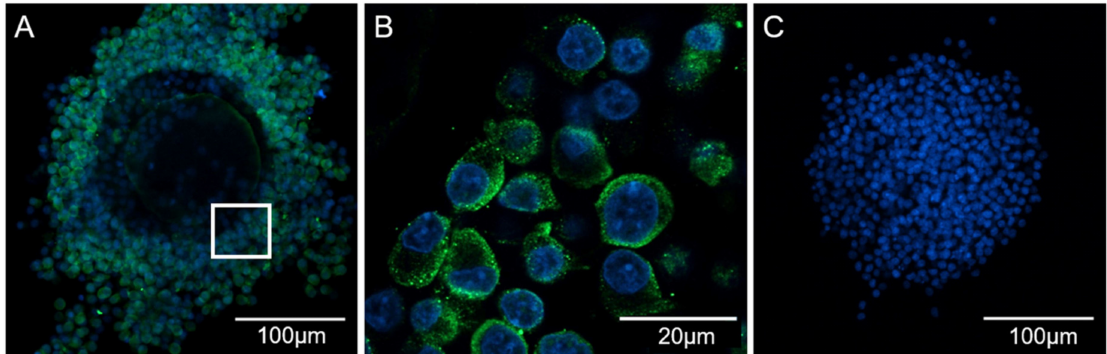
Figure 2. Representative confocal microscopy images of the expression and localization of CXCL12 in porcine mature COCs. From left to right, CXCL12 at different magnifications ( A , B ), control staining with blocking peptide showing COCs nuclei ( C ). Blue: nuclei (Hoechst 33342); Green: CXCL12.